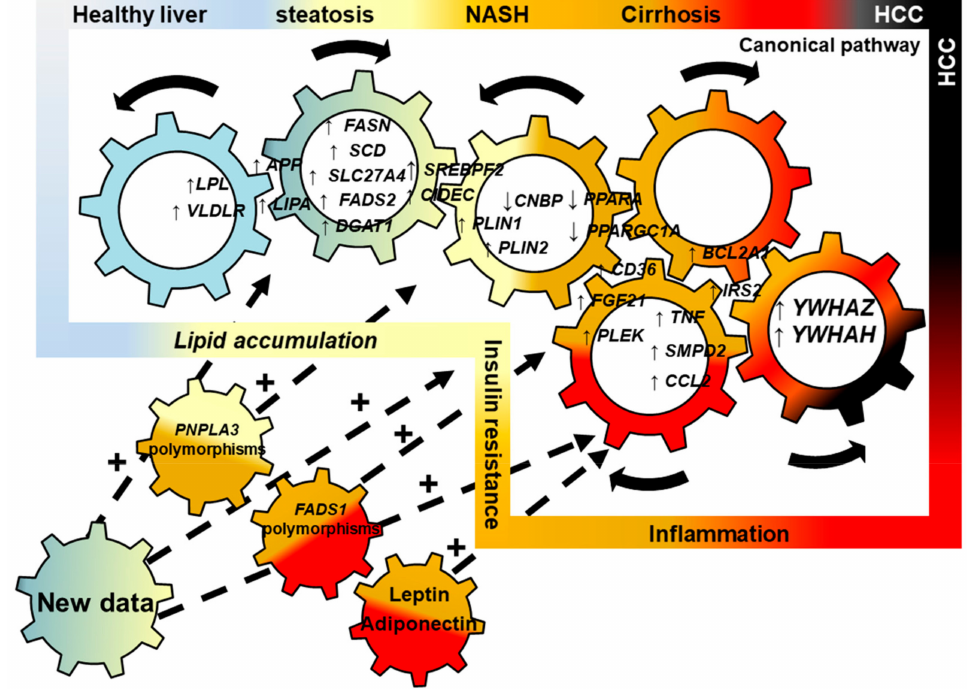
Figure 11. Canonical pathway explaining the NASH progression from steatosis to hepatocellular carcinoma. Inside the box the genes identified by text-mining are represented. The toothed wheels represent the connections between the genes working together to accumulate toxic lipids that will lead to insulin-resistance and then inflammation and hepatocellular carcinoma (HCC). Thus, the steatosis due to an imbalance of lipid metabolism and accumulation of toxic lipids will progress to NASH due to the inflammatory processes and insulin resistance leading to expression of genes involved in tumor progression such as YWHAZ and YWHAH. Outside the box, other genes with specific polymorphisms (e.g., FADS1: fatty acid desaturase 1) or other factors such as cytokines / chemokines (e.g., increase of leptin and / or decrease of adiponectin) will accelerate and / or exacerbate the progression of the disease leading faster to cirrhosis and then HCC. This representation is not frozen but dynamic and can change depending on the future new